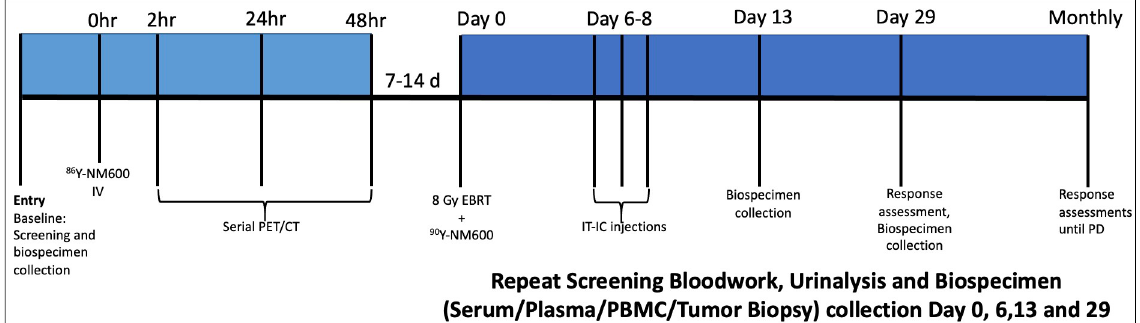
Fig 2. Protocol schema for tumor-bearing companion dogs receiving external beam radiation therapy in combination with intratumoral hu14.18-IL2 immunocytokine and 86/90 Y-NM600 targeted radionuclide therapy.